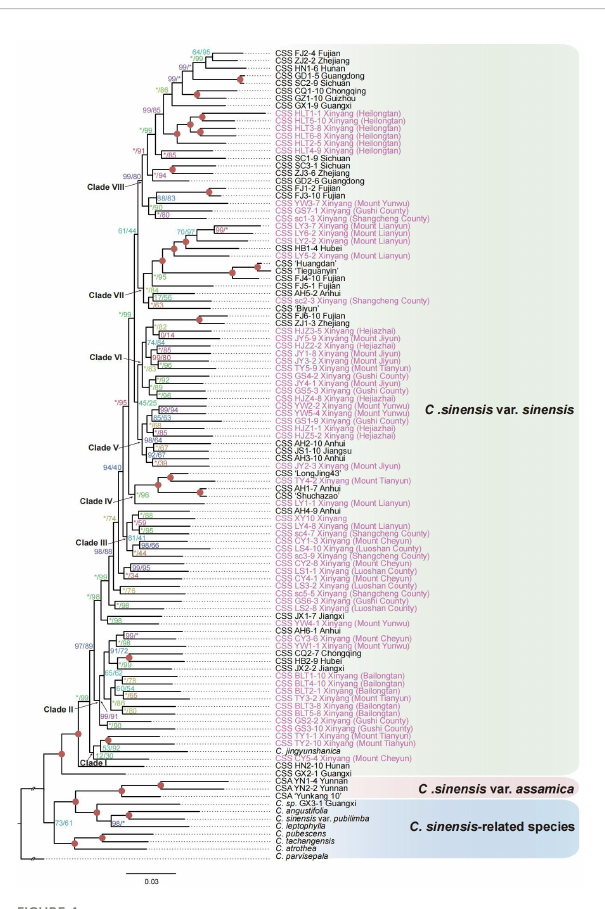
FIGURE 4 The maximum likelihood (ML) phylogenetic tree was inferred from a concatenated supermatrix of 99115 SNPs. The ML tree was reconstructed using IQ-TREE with best- fi t model TVM+F+R4 and ultrafast bootstrap (UFBoot) and H-aLRT test each with 1000 bootstrap replicates. The red circle indicates that the support value of the UFBoot and H-aLRT tests are both 100. The support values of H- aLRT (left) and UFBoot (right) were separated by slashes in the nodes. The asterisk indicates that either H-aLRT (left) or UFBoot (right) support value is 100. CSS, Camellia sinensis var. sinensis ; CSA, Camellia sinensis var. assamica. The purple color was used to mark the samples collected in the Xinyang